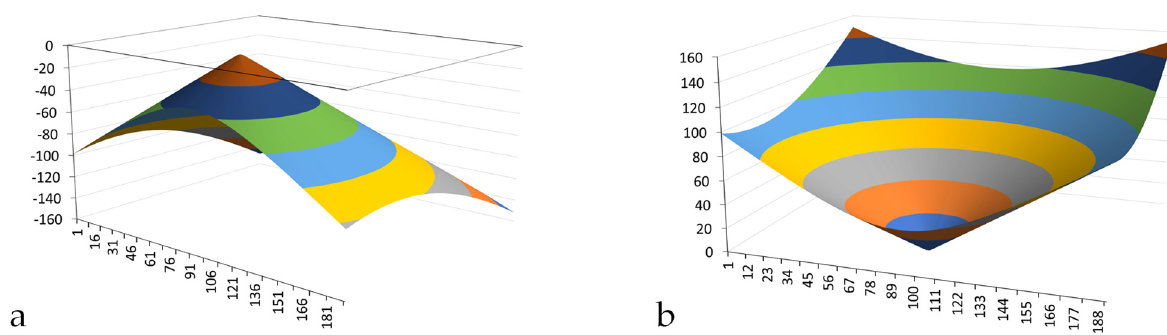
Figure A18. The conceptual potentiometric surfaces: ( a ), associated with an infiltration well or injection well in a homogenous confined aquifer, or a homogenous unconfined aquifer; and ( b ), associated with an abstraction well in a homogenous confined aquifer, or homogenous unconfined aquifer. Fluid flow is in the direction of decreasing potential. x-,y-,z- axial units are meters. Colors are potential expressed in m (head), Pa, or potential. Brown is the highest potential.